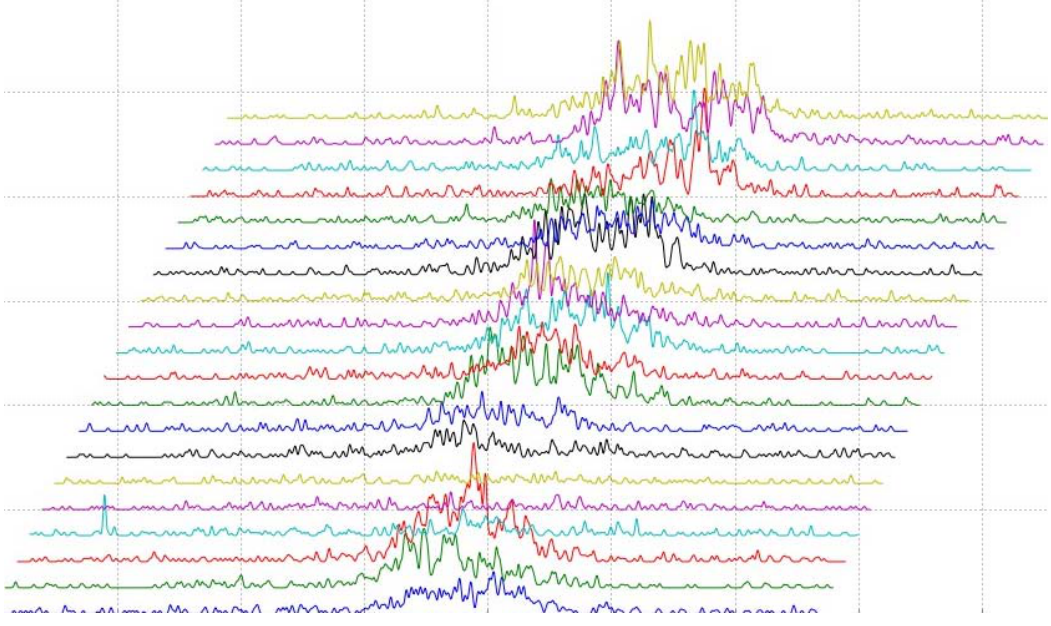
Figure 8. The third harmonic spectrum of 6.6 keV was measured with a single shot spectrometer located in the HEH1.